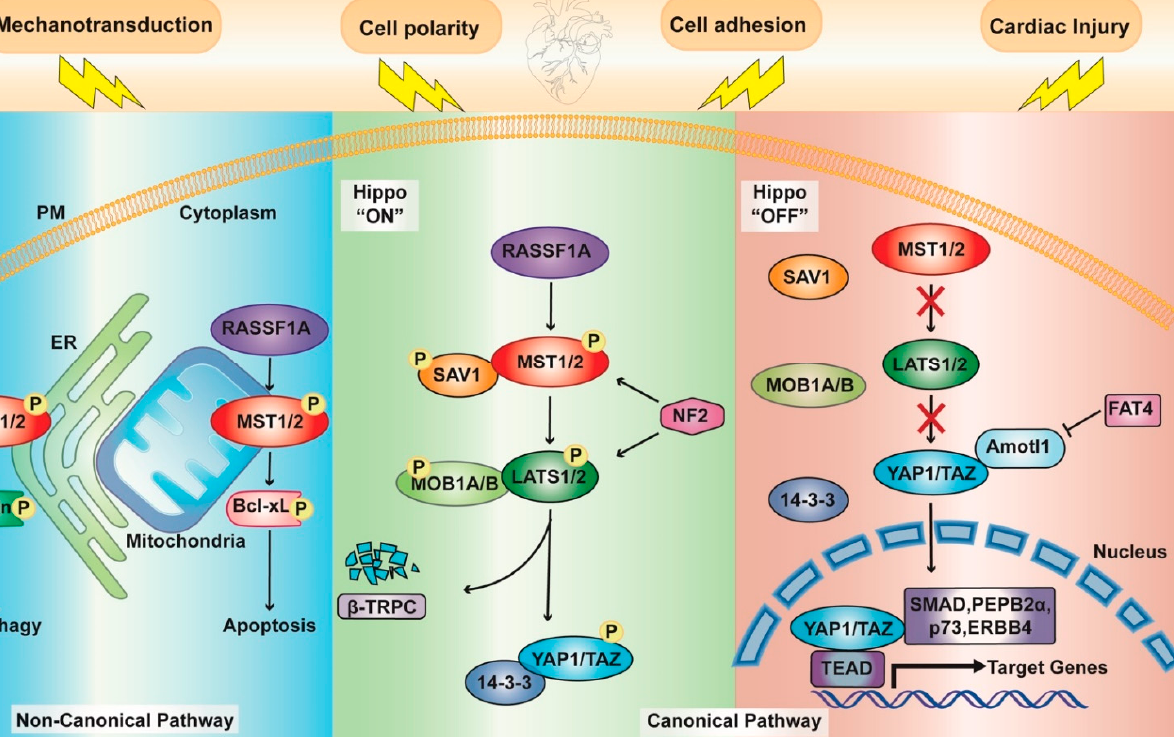
Figure 1. Schematic representation of the key components of the Hippo pathway. Canonical Pathway: In the “on” active state ( central panel ), upstream kinases (MST1/2, LATS1/2) together with their cofactors (SAV1 and MOB1A/B, respectively) are phosphorylated. Subsequential phosphorylation of YAP1/TAZ engages either 14-3-3 proteins for cytoplasmic retention or β -TrCP for ubiquitin-mediated protein degradation. In the “off” inactive state ( right panel ), upstream kinases are inactive; thus, YAP1/TAZ can translocate to the nucleus and bind with multiple transcription factors, including TEADs, SMAD, PEPB2 α , P73, and ERBB4, thereby regulating several genes. The central components of the hippo pathway are regulated by several mechanisms and proteins, such as NF2, Amotl1, and FAT4. Noncanonical pathway ( left panel ): MST1 can directly phosphorylate either Beclin 1 at the ER, inhibiting autophagy in cardiomyocytes, or negatively regulating Bcl-xL at the mitochondria, enhancing cardiomyocyte